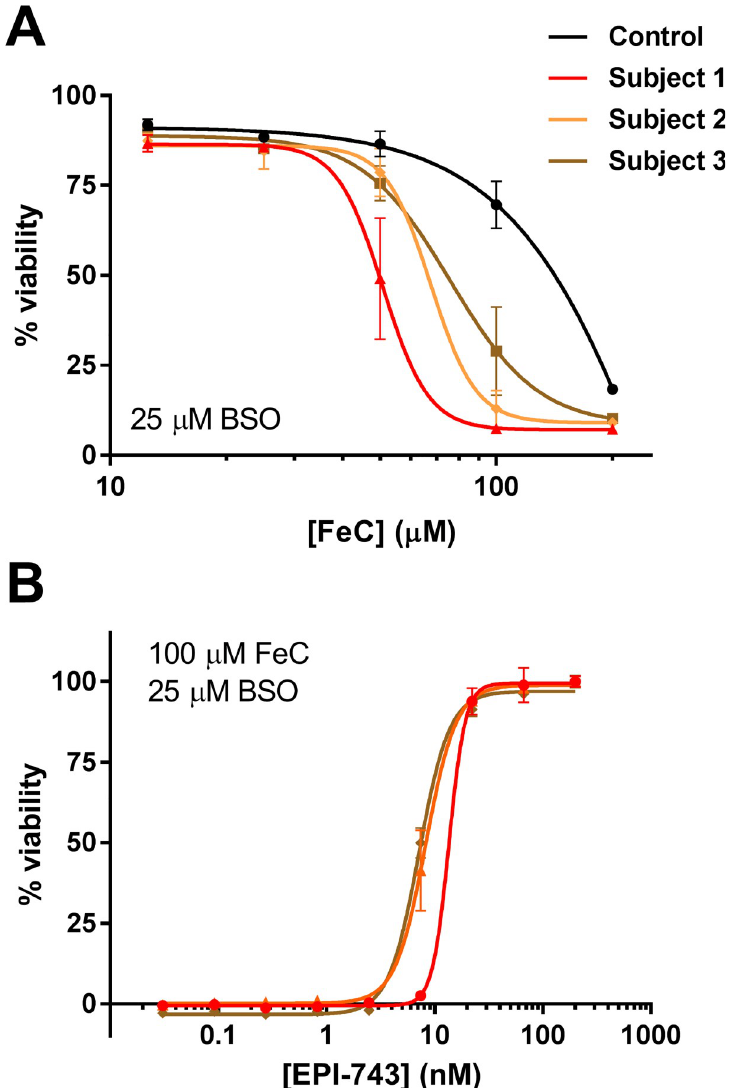
Fig 2. EPI-743 rescues PCH6 patient fibroblasts from iron / BSO-induced ferroptosis. (A) PCH6 patient fibroblasts were sensitive to ferroptosis induced by BSO-mediated GSH depletion in the presence of varying concentrations of added iron(III) citrate (FeC). Viability relative to untreated control wells was measured by Calcein AM assay 48 h after BSO treatment. (B) EPI-743 treatment dose-dependently prevented FeC/BSO-induced ferroptosis in PCH6 patient fibroblasts. Mean ± SEM (N = 3) along with best-fit 4-parameter curve fits displayed; representative of two independent experiments. Refer to Table 2 for summary statistics of calculated rescue potencies.